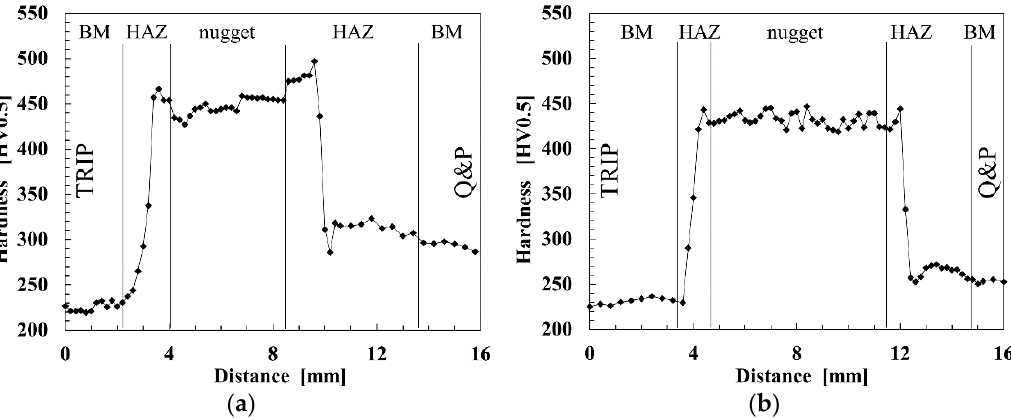
Figure 6. Typical microhardness profiles of the Q&P/TRIP welds. Welding configurations: ( a ) run No. 3 (6 kA, 4 kN, 450 ms); and ( b ) run No. 7 (9 kA, 2 kN, 450 ms).